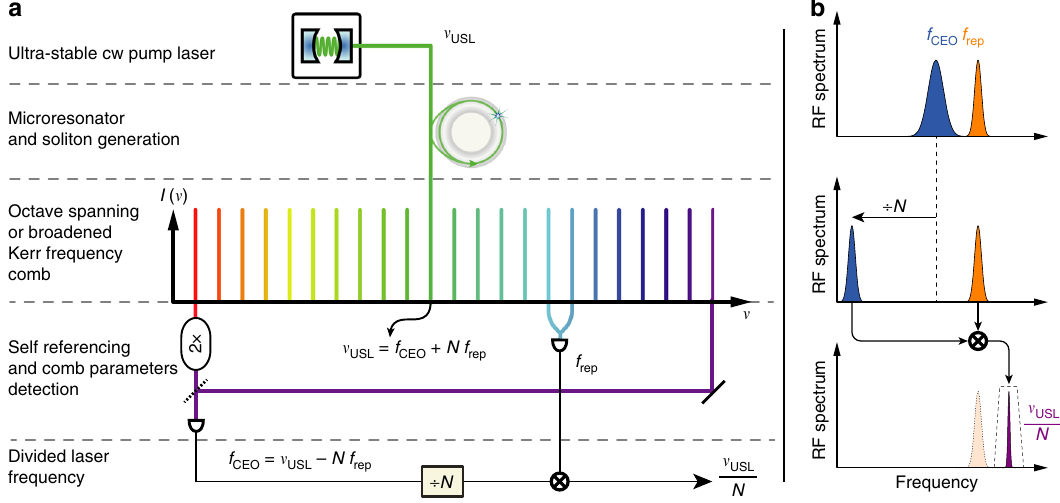
Fig. 1 Principle of operation of the Kerr comb-based transfer oscillator. for optical-to-microwave frequency division. a Schematic illustration of the transfer oscillator applied to a Kerr comb (or electro-optic combs equivalently). b Schematic representation of the signal evolution along the electronic division chain leading to the low-noise output signal. The two comb parameters f CEO and f rep are detected. Both parameters can be free-running and fl uctuate. The carrier envelope offset (CEO) frequency is electronically divided by a large number N that corresponds to the tooth number of the ultra- stable pump ν USL . After this step, the frequency fl uctuations of the divided CEO f CEO ∕ N = ν USL ∕ N − f rep are dominated by the repetition rate fl uctuations. These are removed by mixing f CEO ∕ N with f rep to obtain the division result ν USL ∕ N . A narrow-band fi ltering is used to reject